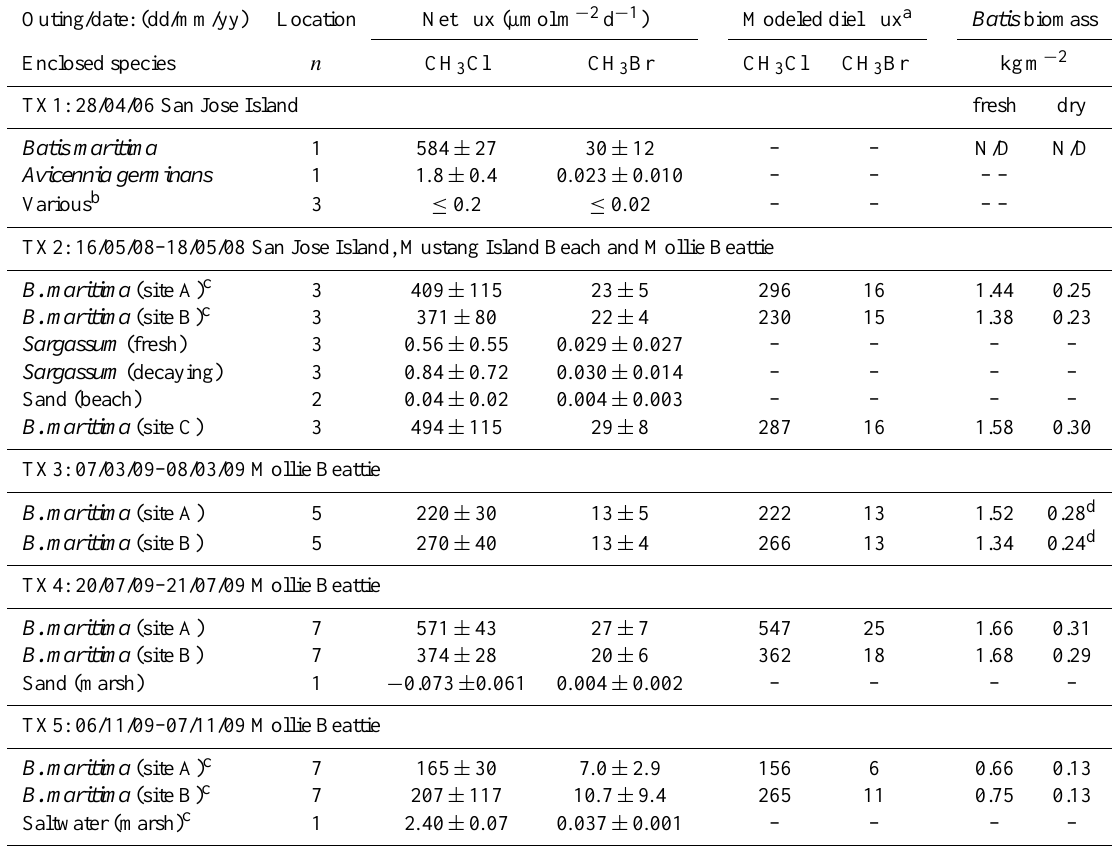
Table 1. Field conditions and predominant vegetation at Texas coastal field sites. Outing/date: